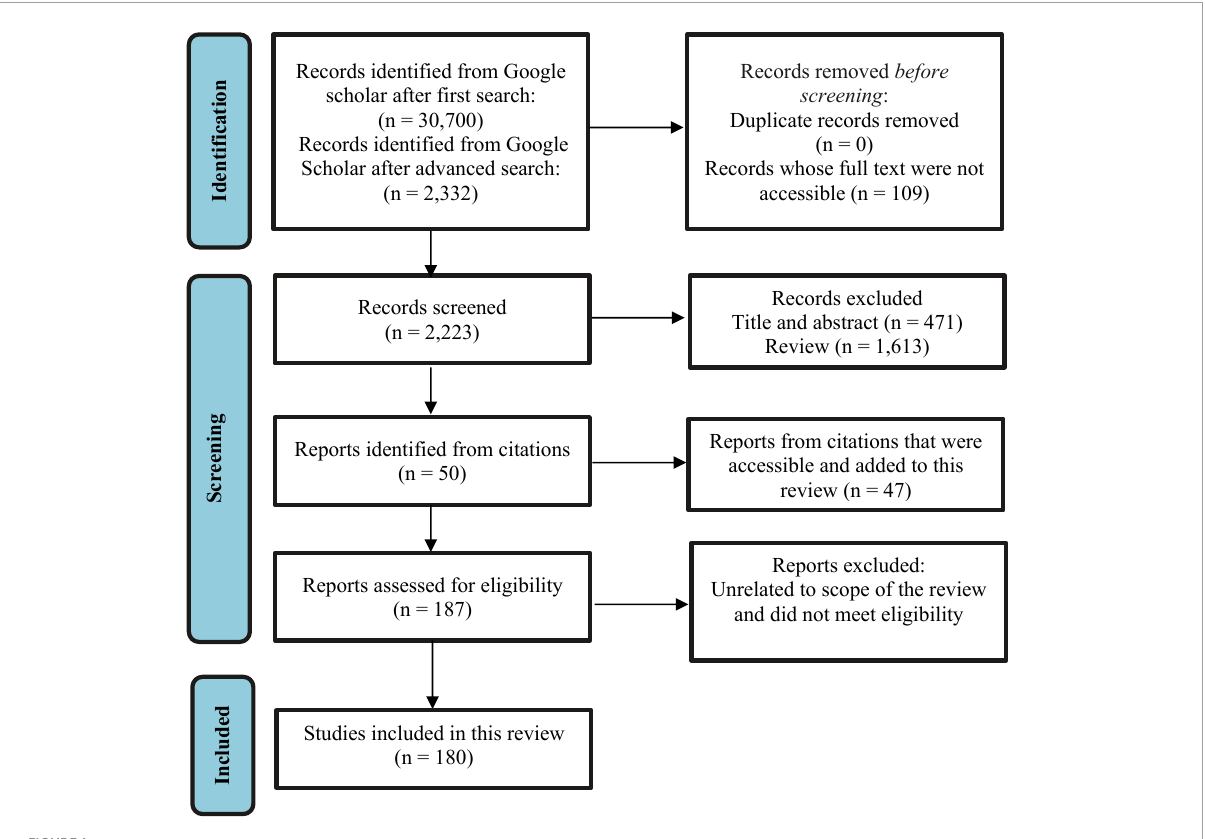
FIGURE1 Flow diagram of information search for the systematic review